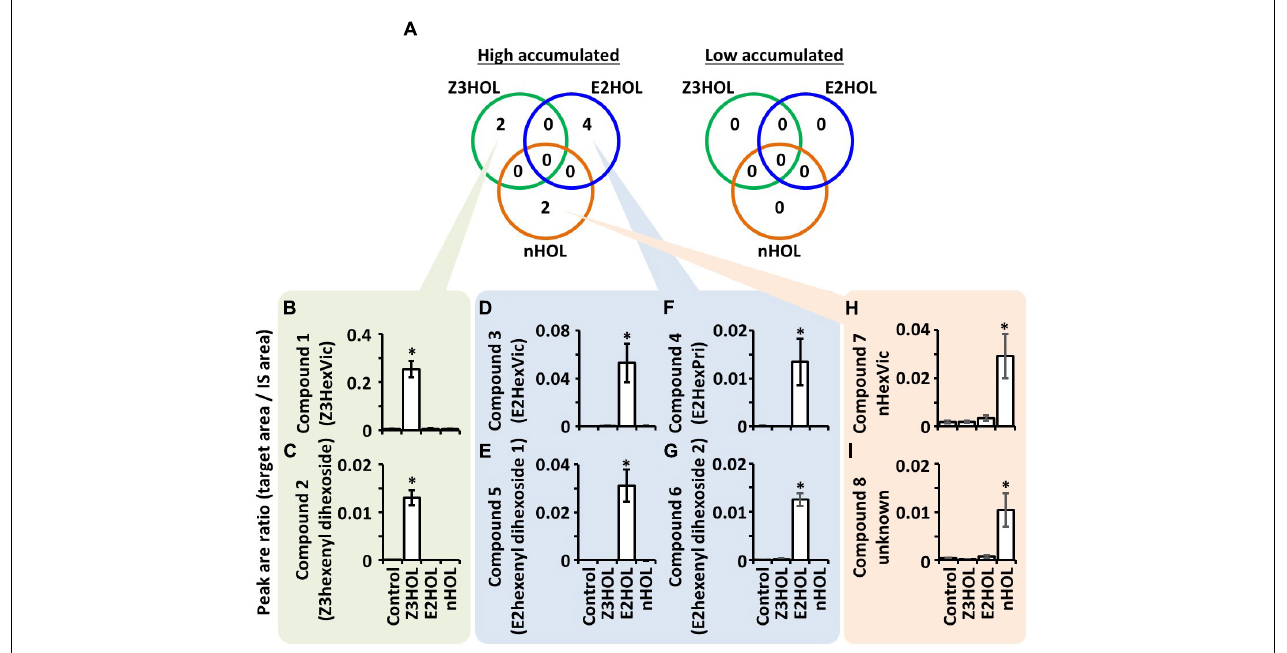
FIGURE 2 | Differentially accumulated compounds in tomato leaves exposed to the green leaf alcohols. (A) Numbers in the green, blue, and orange circles represent the differentially accumulated compounds in Z3HOL-, E2HOL-, and nHOL-exposed tomato leaves, respectively. The number of high-accumulated compounds in Z3HOL-, E2HOL-, and nHOL-exposed samples (2, 4, and 2, respectively). No overlapping compounds were found among exposed volatile species. (B–I) The relative quantity of each compound is shown in bar graphs (* p < 0.05; Dunnett test). The raw data is available in the Supplementary Data .